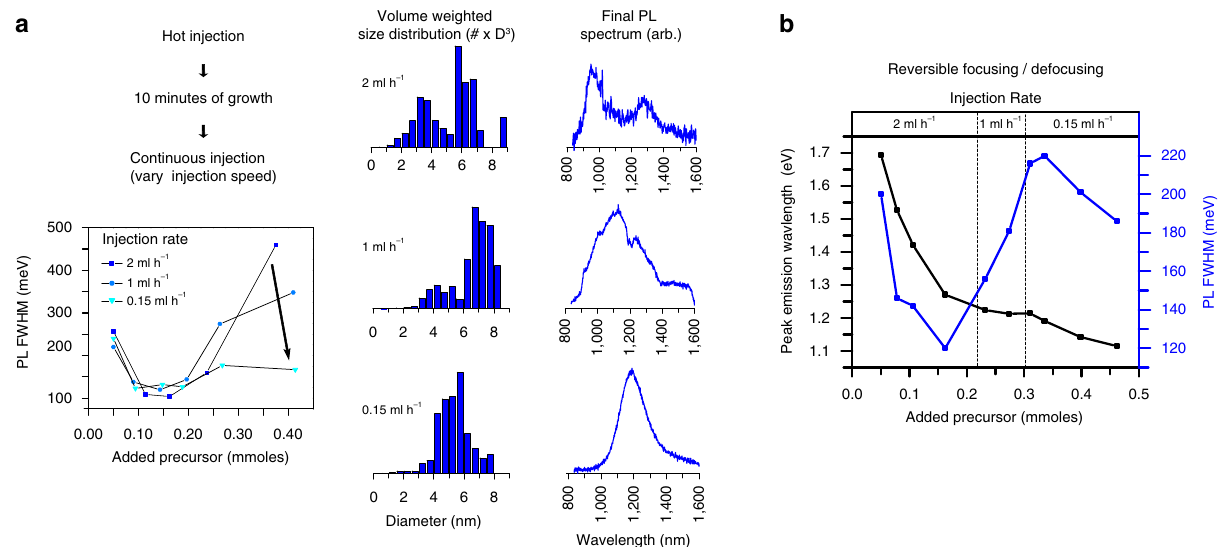
Figure 2 | Kinetic insights into the growth of InAs QDs. ( a ) Influence of the injection rate on the extent of size-focusing. At early stages of QD growth, size-focusing appears invariant to injection speed. However, at later stages, QD growth slows down and fast injection speeds lead to a secondary nucleation event, resulting in a bimodal size distribution, as identified by TEM and two distinct PL peaks (the feature at 1,200nm in the emission spectrum of the 1mlh (cid:3) 1 injection rate originates from solvent reabsorption). Slow injection speeds, however, are able to maintain the system in a size-focused regime, providing access to large particles with narrow size distributions. ( b ) Variation of injection speed during growth within a single synthesis shows the capabilities of our approach. At the beginning of the reaction fast injection speeds bring the system into a size-focusing regime. As soon as growth slows down, as can be seen from the PL peak values slowly converging over time, size-broadening sets in. A drastic decrease in injection rate, however, can be used to push the system back into a size-focusing growth regime, yielding a second onset of QD growth and a partial reversion of the occurred size-